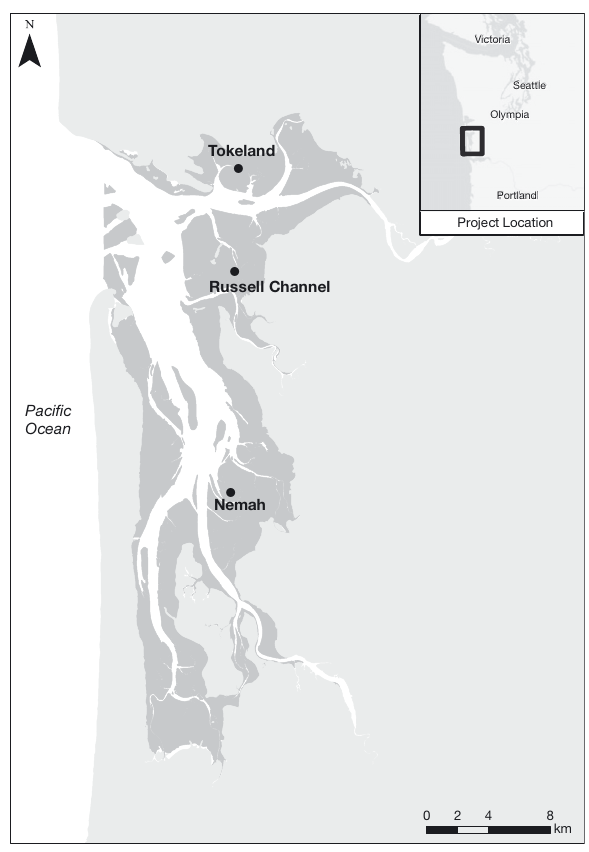
Fig. 1. Sampling sites within Willapa Bay, Washington, USA. Each site included off-bottom and on-bottom aquaculture adjacent to an established eelgrass